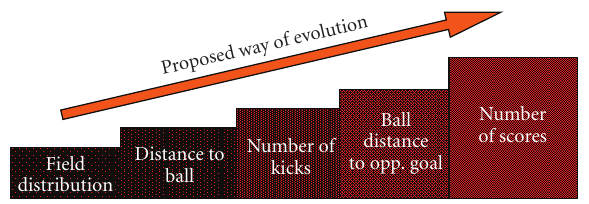
Figure 4: Weighted fitness.